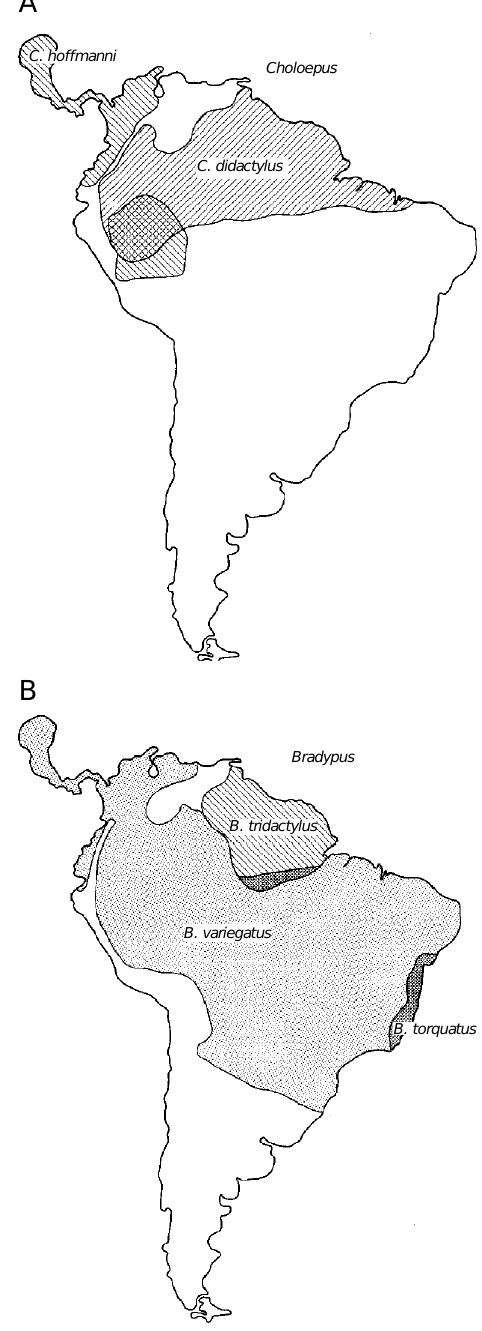
Figure 1 - Distribution of two- and three-toed sloths through- out Central and South America (A, B) (for further details see Wetzel